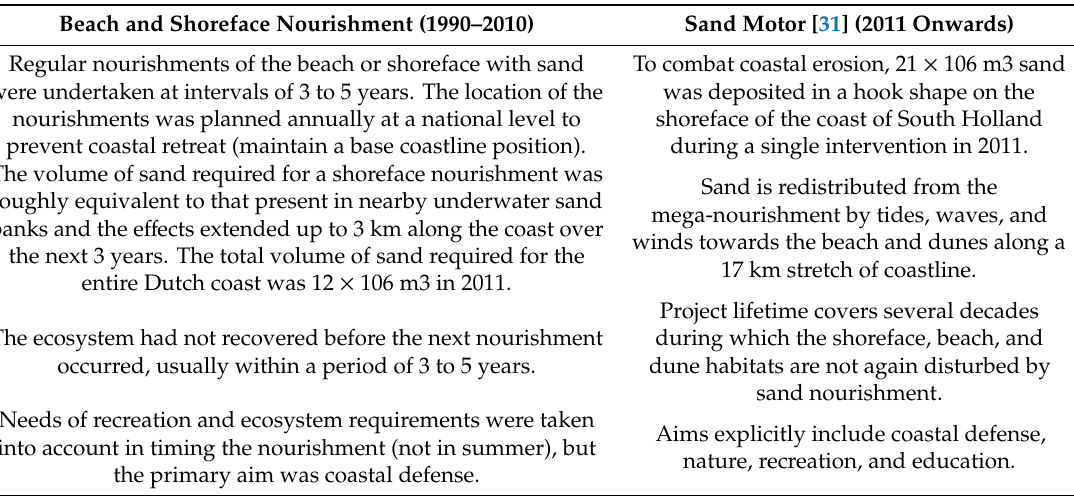
Table 2. Beach nourishment on the South Holland coast demonstrating the metamorphosis in hydraulic